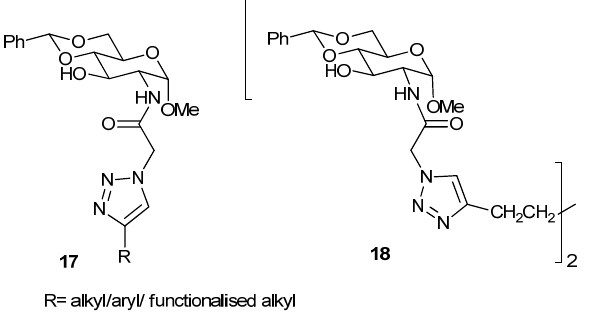
Figure 14. Triazolyl anchored D ‐ glucosamide based glycolipids.